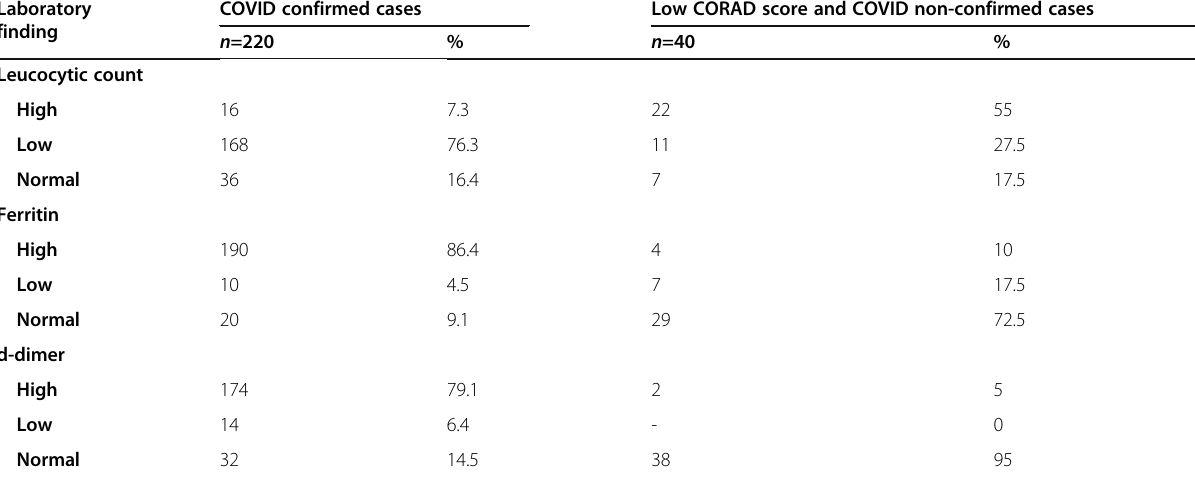
Table 3 Laboratory finding in the cases